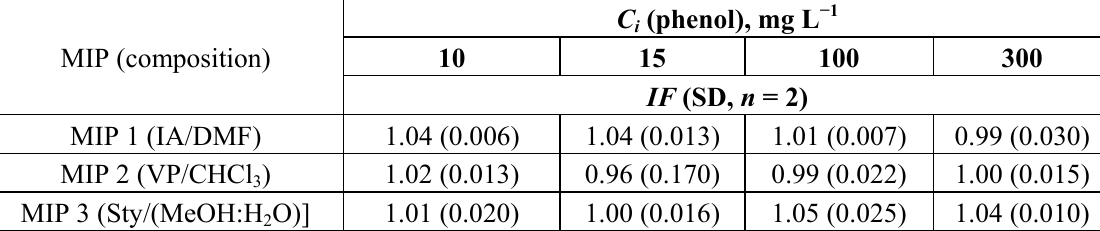
Table 2. Imprinting factors for MIP formulations prepared on different